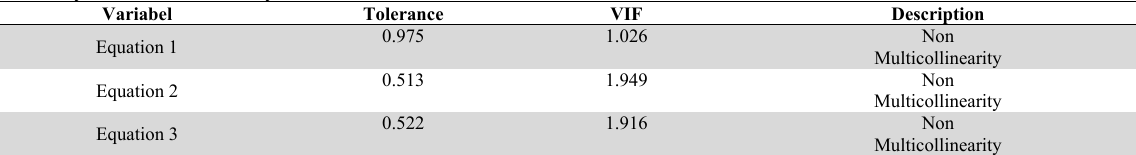
Summary of Multicollinearity Test